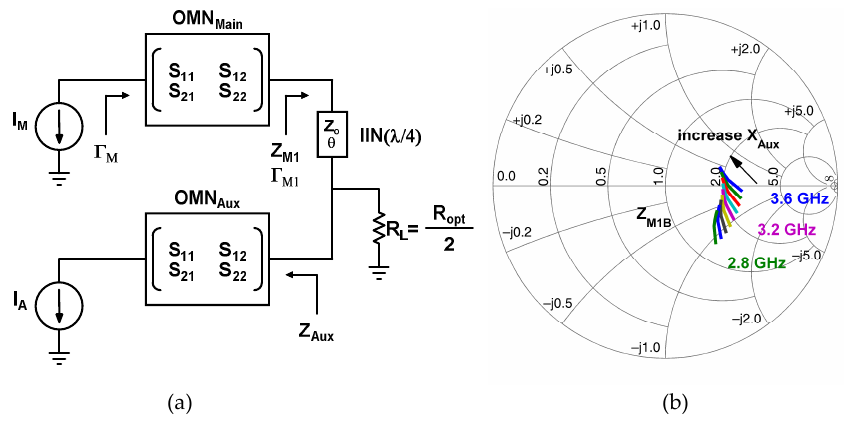
Figure 5. ( a ) Block diagram of the output matching networks. ( b ) Variation of the Z M1B versus f (from 2.8GHz to 3.6GHz) and X Aux (from 40 Ω to 500 Ω ) when the auxiliary power amplifier (PA) is